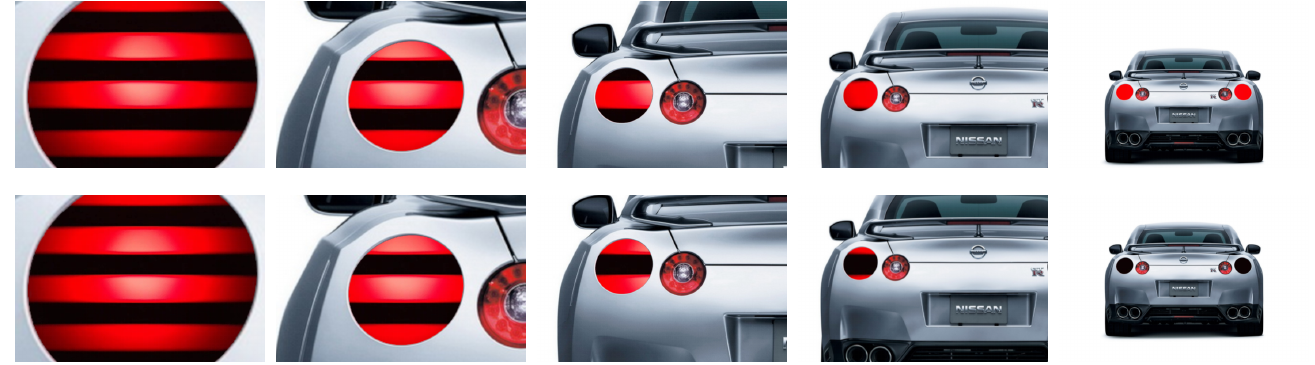
( a ) LED on. Figure 4. Stripe pattern occurs when capturing a flickering LED with a rolling-shutter camera.